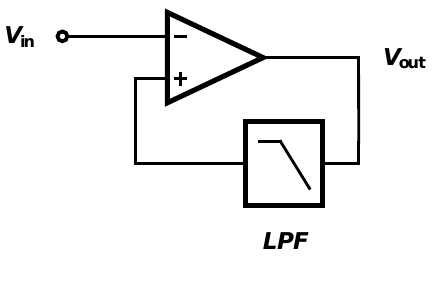
Figure 17. General architecture of dc-coupled